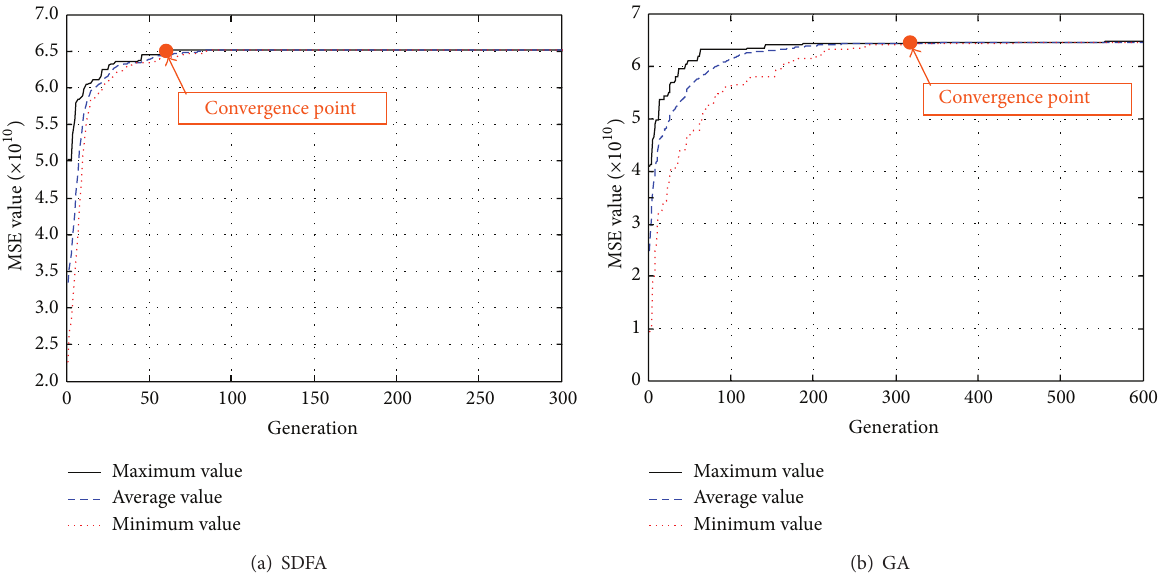
Figure 2: Iteration progress of the objective